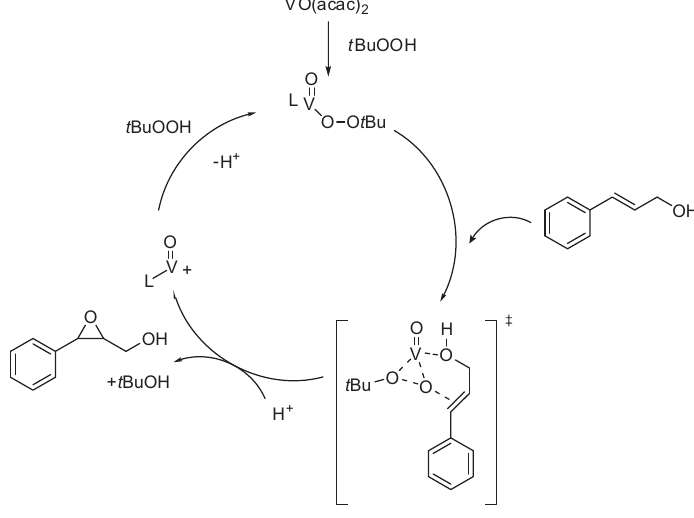
Figure 3 Proposed mechanism for the epoxidation reaction of cinnamyl alcohol to 3-phenylglycidol.